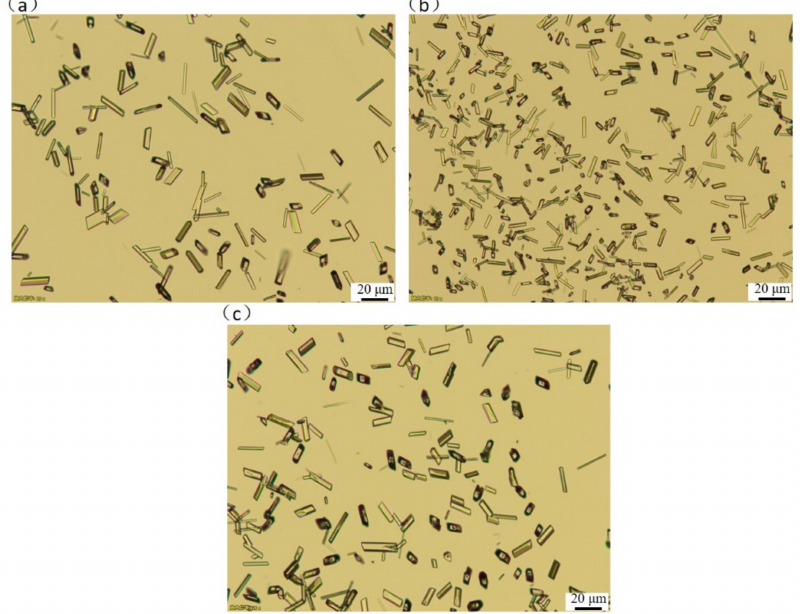
Figure 8. Crystal morphology of PMBA at ethanol mass fraction of ( a ) 0.6, ( b ) 0.8, and ( c ) 1.0 (saturation temperature 293.15 K, cooling rate 20 K/h, the scale in all figures is 20 µ m).